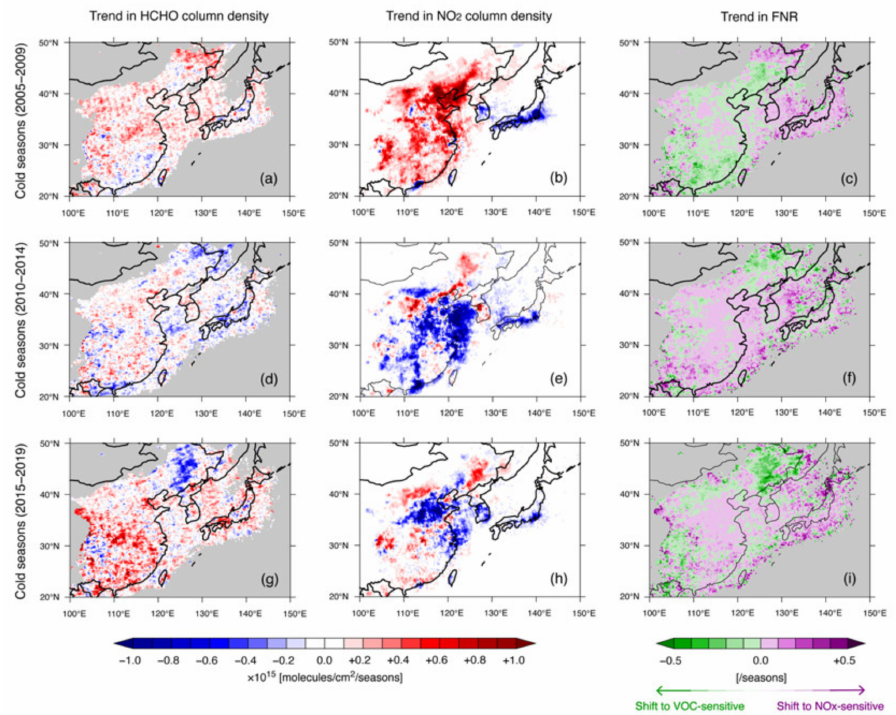
Figure A1. Linear regression analyses for ( a , d , g ) HCHO column density, ( b , e , h ) NO 2 column density, and ( c , f , i ) FNR over East Asia during the 5-year periods of ( a – c ) 2005–2009, ( d – f ) 2010–2014, and ( g – i ) 2015–2019 averaged over the cold seasons. HCHO column density and FNR are analyzed at grid points where NO 2 column density is greater than 1.0 × 10 15 molecules cm − 2